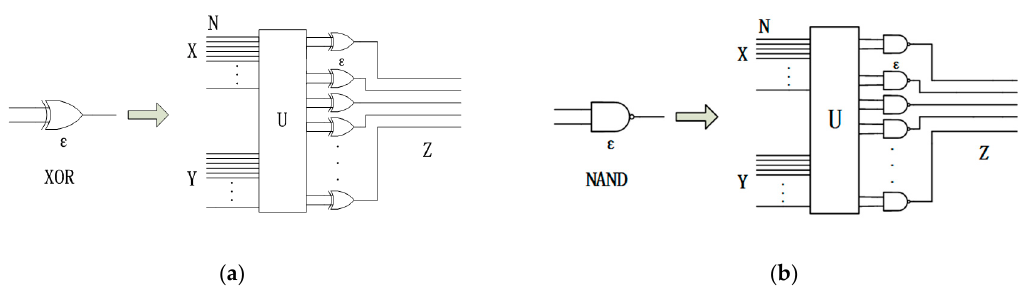
Figure 1. The XOR and the NAND multiplexing unit: ( a ) The XOR multiplexing unit; ( b ) The NAND multiplexing unit.